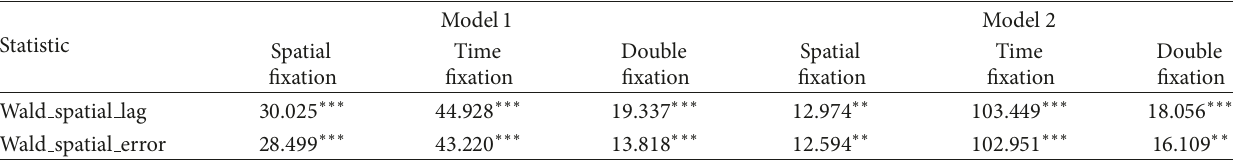
Table 3: Wald test results of